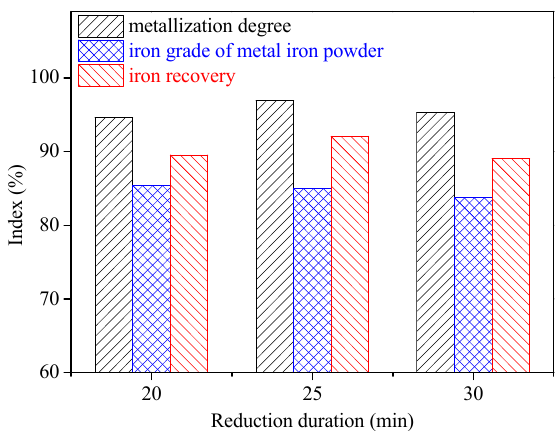
Figure 11. Effect of reduction duration on the reduction and separation indexes (reducing at 1350 °C with a total C/Fe mass ratio of 1.0, 15% coal blended in pellets).